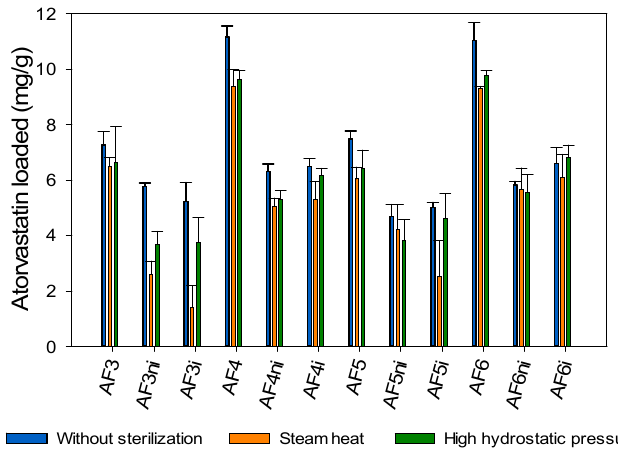
Figure 8. Atorvastatin loaded, after 48 h soaking, by hydrogels that had not been sterilized (blue bars) and hydrogels sterilized by steam heat (orange bars) or high hydrostatic pressure (green bars) before the loading. Codes as in Table 1 ( n = 4; mean values and standard deviations).